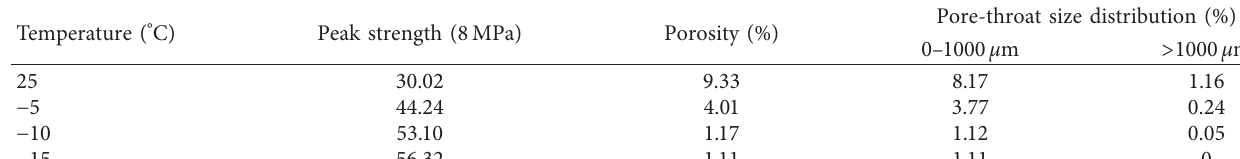
Table 5: Porosity and pore-throat size distribution and peak strength.